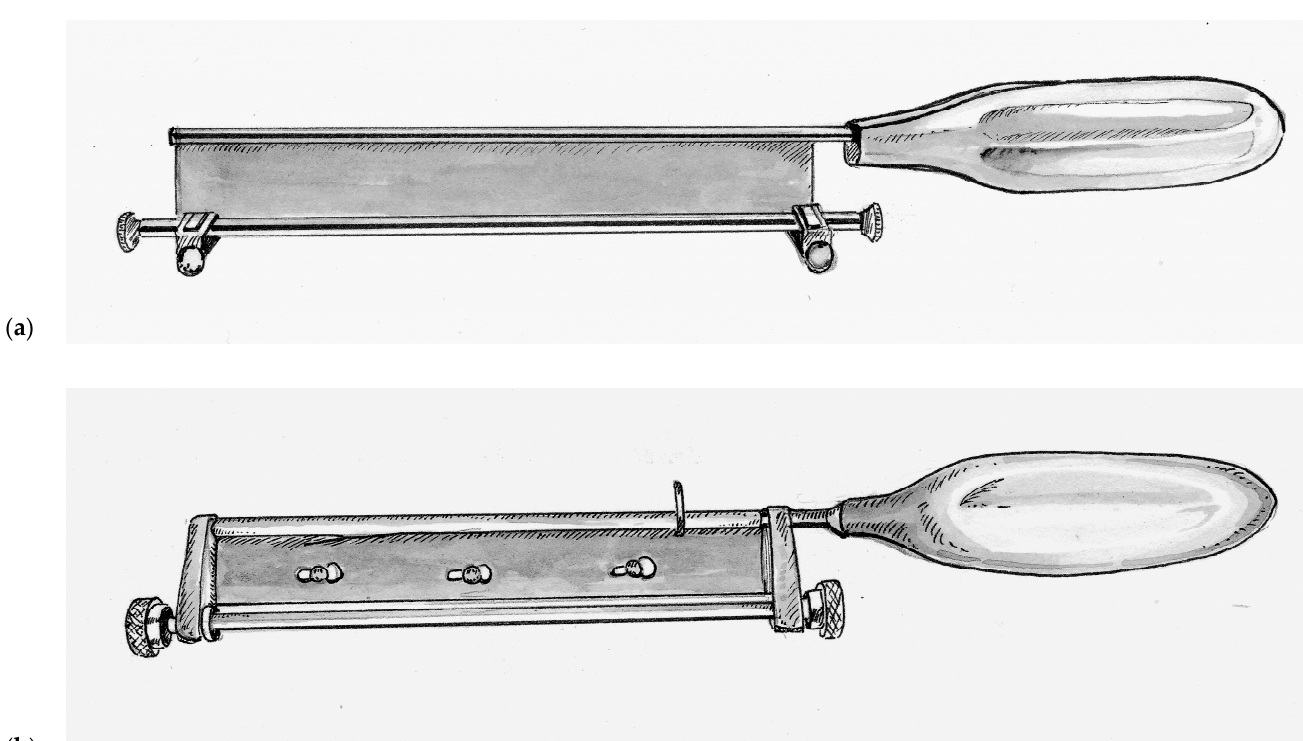
Figure 2. Skin grafting knives with modifiable depth: ( a ) The Humby knife in 1934; ( b ) The Watson knife in 1960.